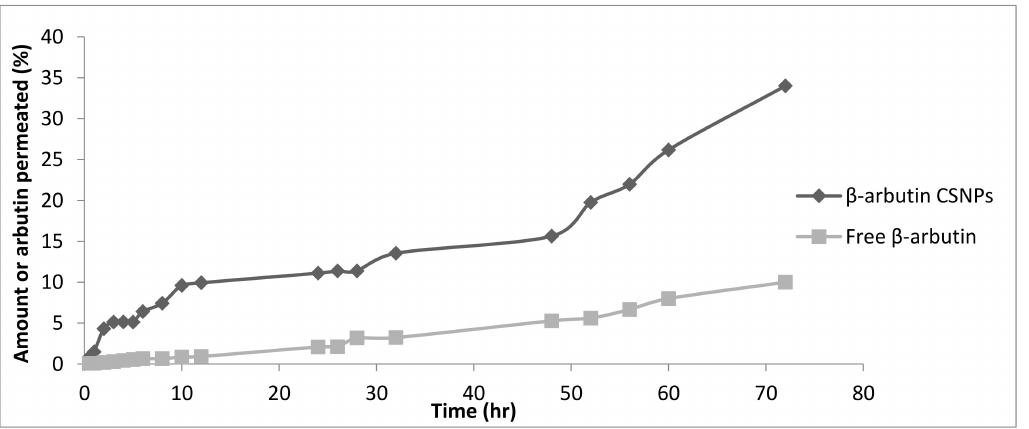
Figure 7. In vitro permeation studies of 0.4% β -arbutin CSNPs and free β -arbutin. ( t -test, p <